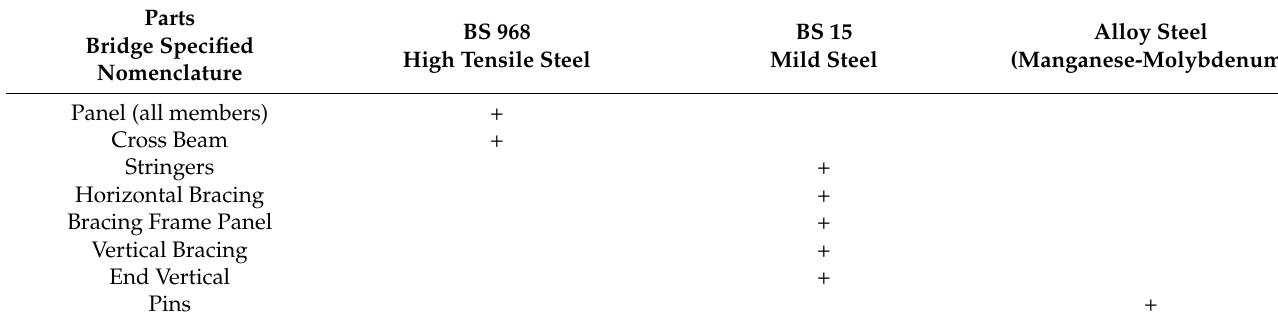
Table 4. Steel property assignation on bridge